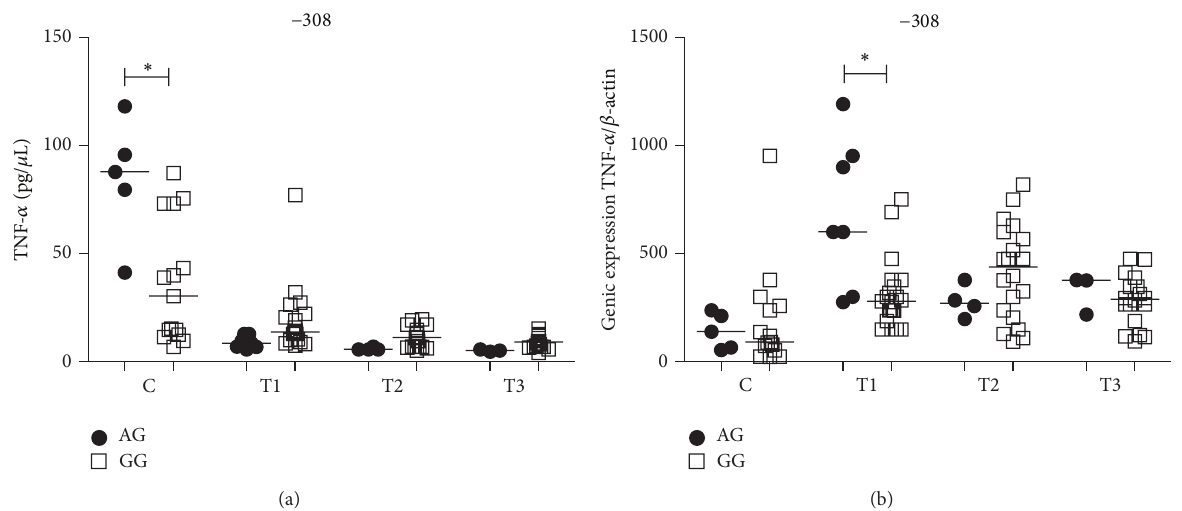
Figure 4: Influence of TNF − 308G/C gene SNP on TNF- 𝛼 plasma levels (a) and mRNA expression (b) in the control group (C) and PTB patients group at three time points of the treatment: T1 (after diagnosis and first month), T2 (three months), and T3 (six months). Data are shown as median levels. ∗ 𝑃 < 0.05 .